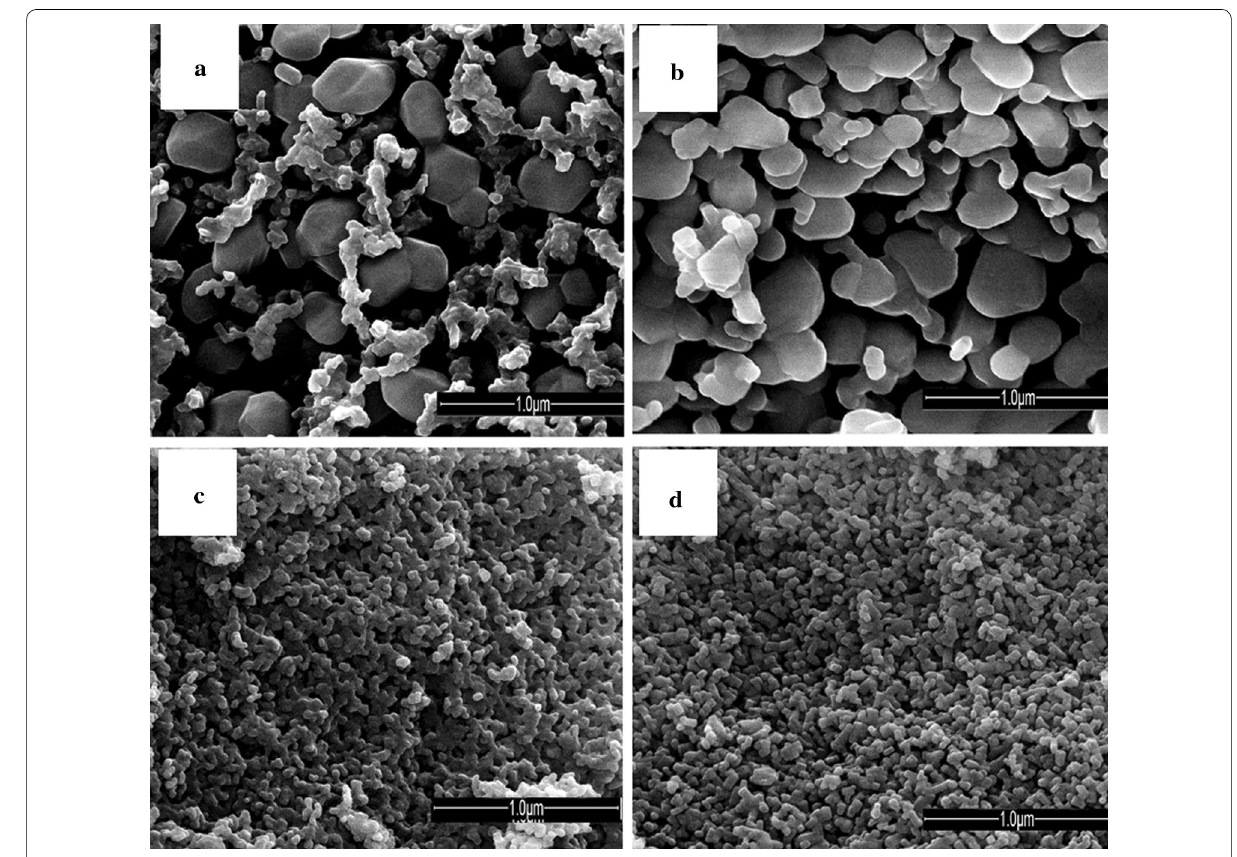
Fig. 3 SEM images of samples 3 ( a ), 9 ( b ), 6 ( c ) and 12 ( d ) heated to 700